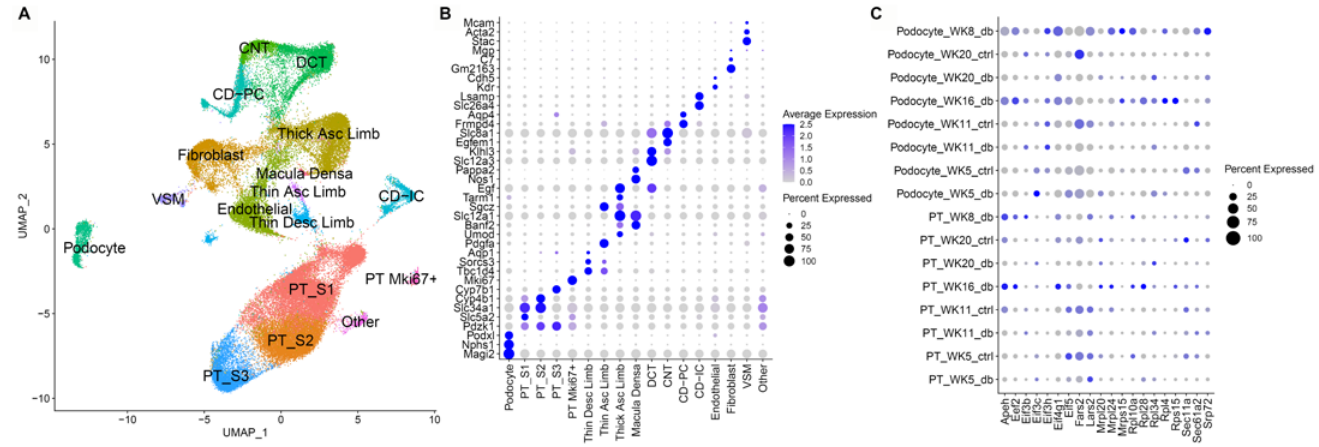
Figure 4. Single nuclear-sequencing analysis of kidney tissue between diabetic and control mice. ( A ) Uniform Manifold Approximation Projection (UMAP) of 17 kidney sub-segments. Dot plot highlighting selected genes used to ( B ) classify sub-segments and ( C ) representative genes altered in translation between diabetic and controls.